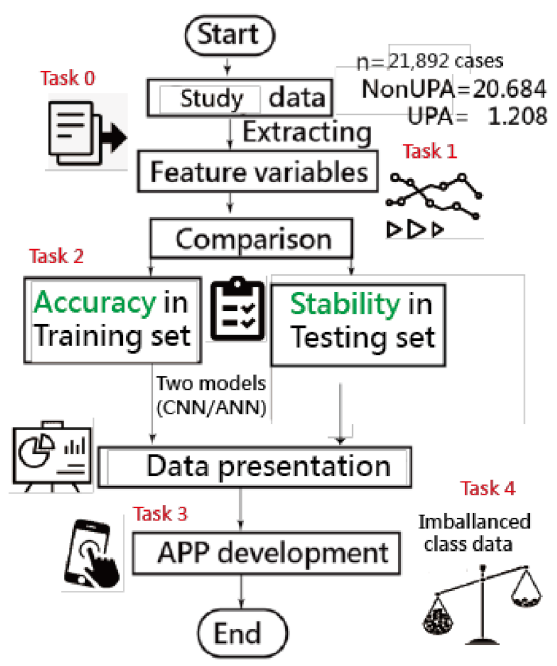
Figure 2. Study flowchart (four major tasks to achieve).